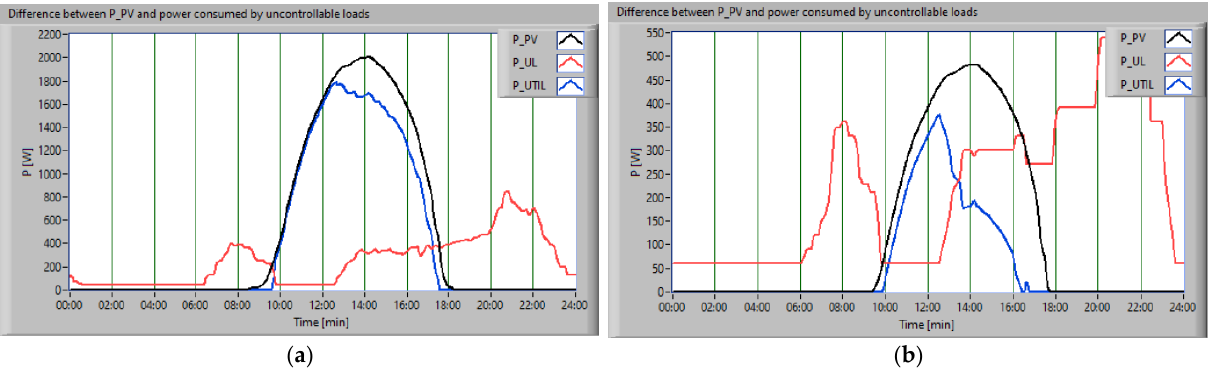
Figure 10. The difference between P PV generated and the consumption of uncontrollable loads, for ( a ) scenario 1; ( b ) scenario 2.